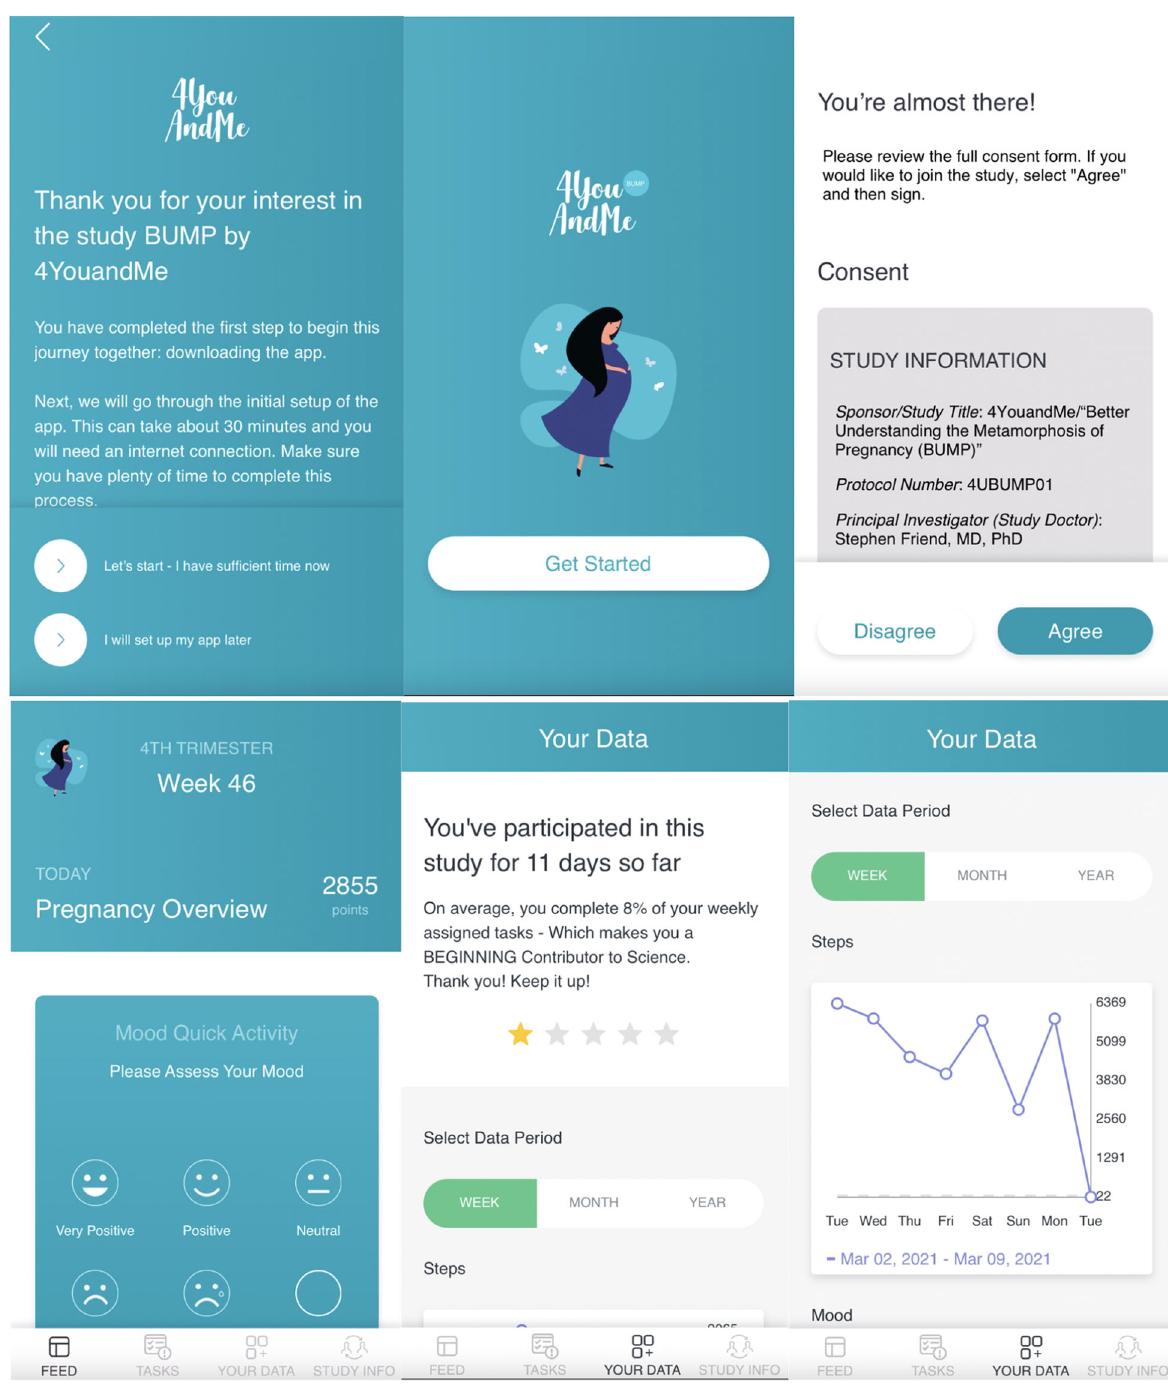
Fig. 2 Sample screenshots from the BUMP study app. Select sample screenshots from the BUMP study app onboarding and e-consent (top 3 panels), quick activities (ecological momentary assessments) (bottom left panel), and the ‘ Your Data ’ tab that tracks participation and returns select symptom summaries back to participants (bottom middle and right